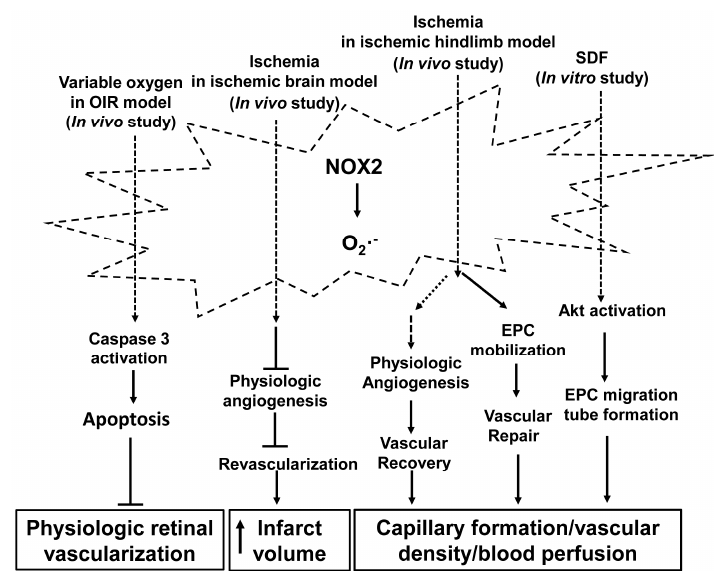
Figure 1. Activation of nicotinamide adenine dinucleotide phosphate (NADPH) oxidase 2 (NOX2) in physiologic angiogenesis. NOX2 is activated by stimuli, including fluctuations in oxygenation, ischemia, and stromal-derived factor (SDF), and generates the superoxide radical that mediates physiologic angiogenesis through signaling pathways involved in physiologic retinal vascularization, vascular restoration through revascularization in brain and hindlimb ischemic models, and vascular repair through endothelial progenitor cells (EPCs). The stimuli designate pathways that have been reported in the literature but do not imply exclusivity. ( ┴ : inhibit; → : promote). OIR: oxygen-induced retinopathy.